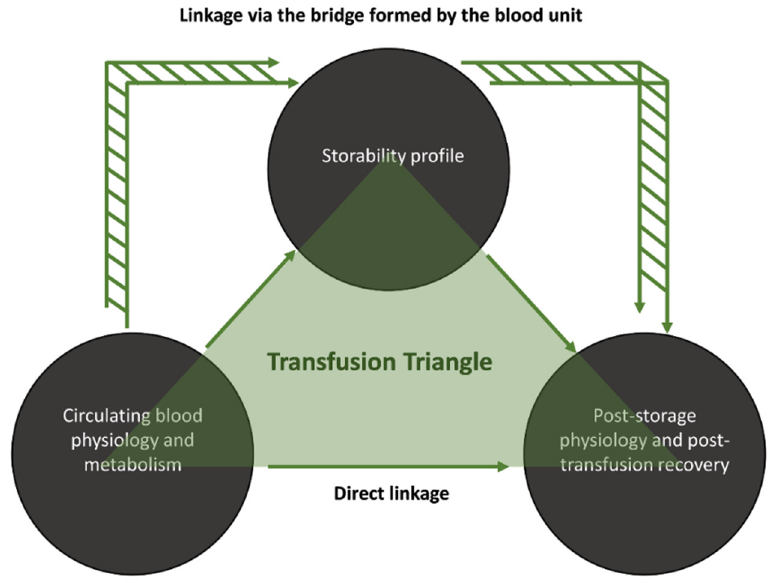
Figure 1. Study design. Proposed routes for the linkage between donor parameters and post-storage/post-transfusion variables.